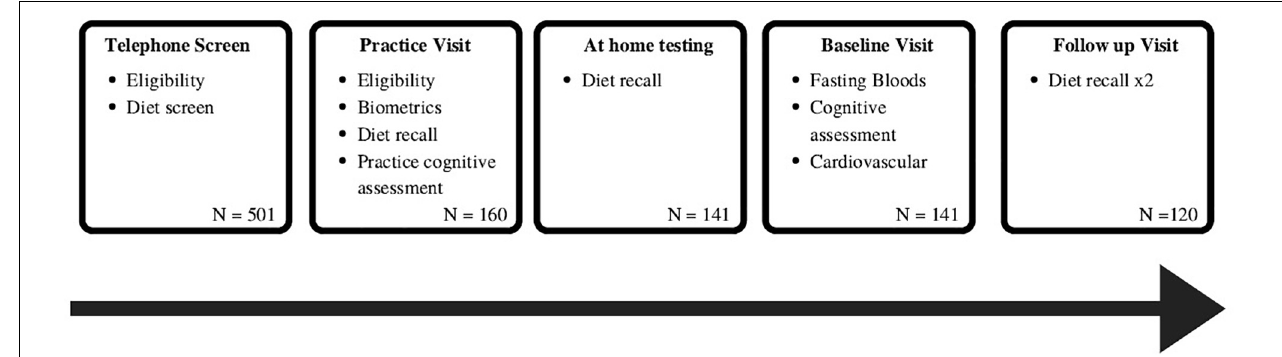
FIGURE 1 | Flowchart of participants included in the study and schedule of assessments used in this